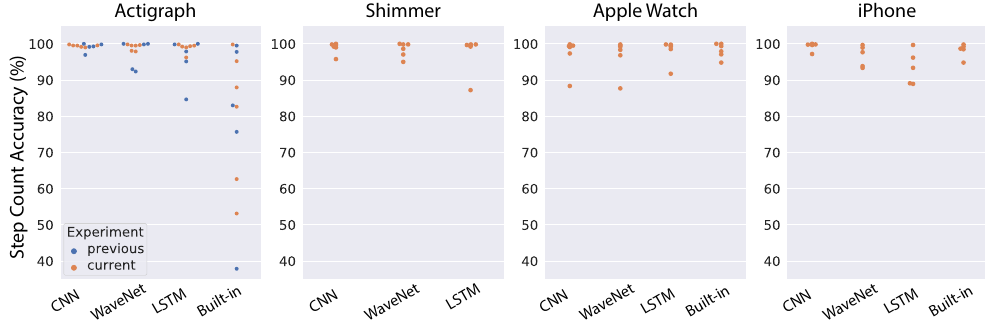
Figure 11. Results of testing the personalized models on an independent dataset using ENMO. Each dot correspond to one subject (blue dots indicate data in [38]). Table 4. Step-count accuracy of personalized models on independent dataset using ENMO.